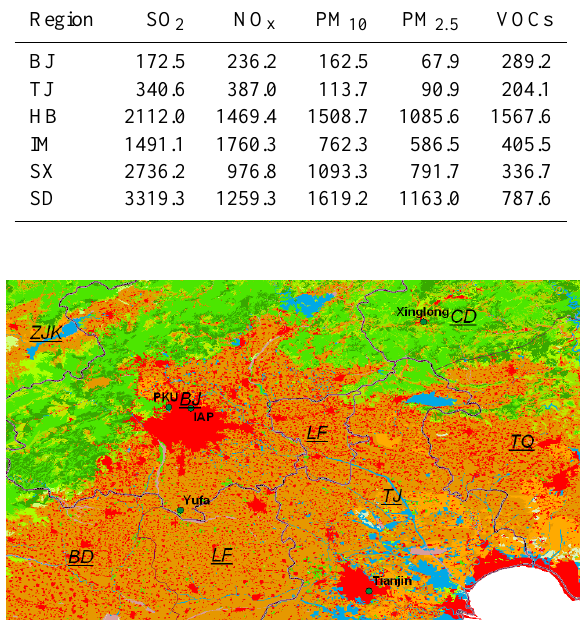
Fig. 2. The location of the observation stations (IAP, Yufa and Xinglong), red shaded indicates urban area, dark green indicates forest, light green indicates grass, orange indicates crop, blue indicates water.